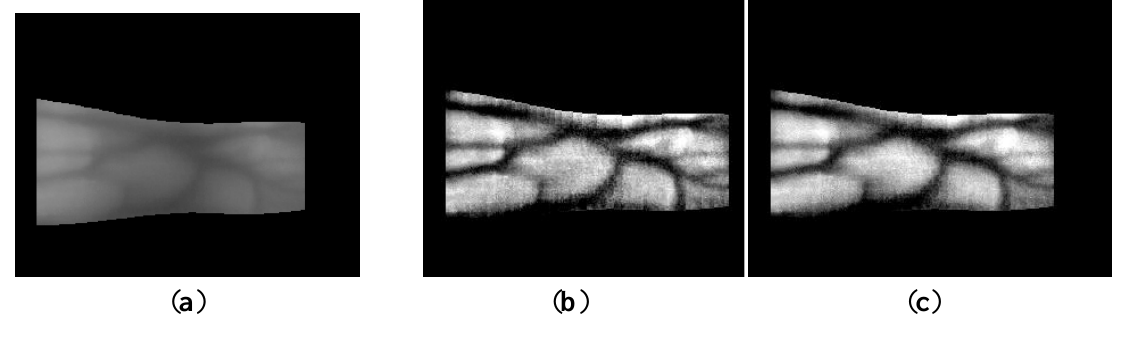
Figure 8. Retinex images obtained using various sigma values with images from database II: ( a ) the original image with the detected finger boundaries; Retinex images obtained using sigma values of ( b ) 10, ( c ) 15, ( d ) 20, ( e ) 25, and ( f )